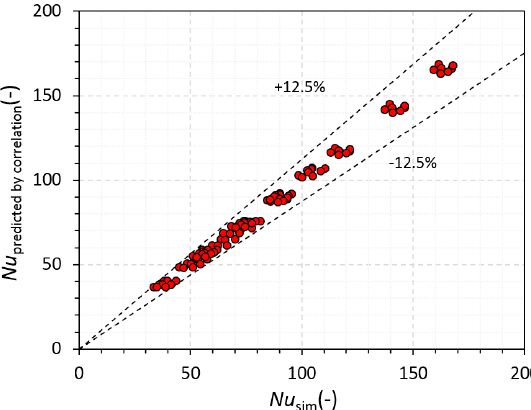
Figure 19. Comparison of simulation and predicted values of Nusselt number.